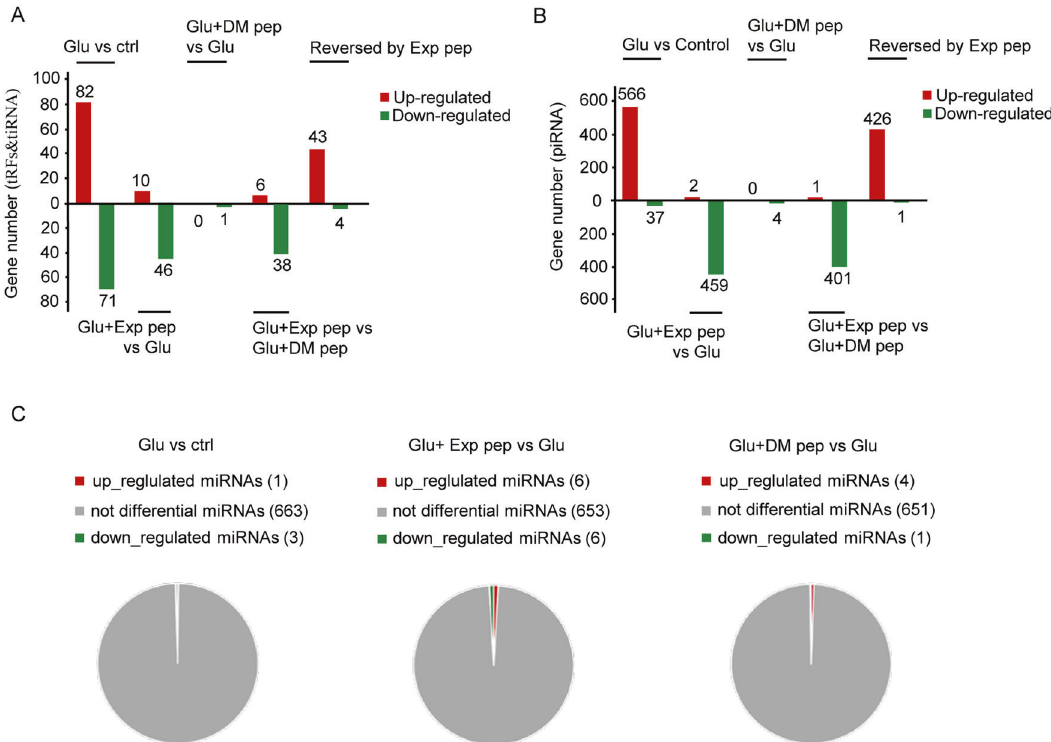
Fig. 1 Pro fi le of non-coding RNAs in neuronal necrosis. The rat embryonic primary neuron cultures were treated with the following conditions: control (no treatment), glutamate treatment, treatment with glutamate and Exp pep, and treatment with glutamate and DM pep. Then, total RNAs were collected, sequenced, and analyzed accordingly. The number of changes of different RNA species were compared for the treatment condition indicated on the graph. tRFs & tiRNAs ( A ), piRNAs ( B ), and miRNAs ( C ) were listed separately. The Y axes are the upregulated or downregulated number of transcripts, indicated by the red column and green column, respectively. The change of more than 50% is set as the cutoff with P- value < 0.05. Three independent samples were collected for each treatment. These three samples were treated as a group to compare between